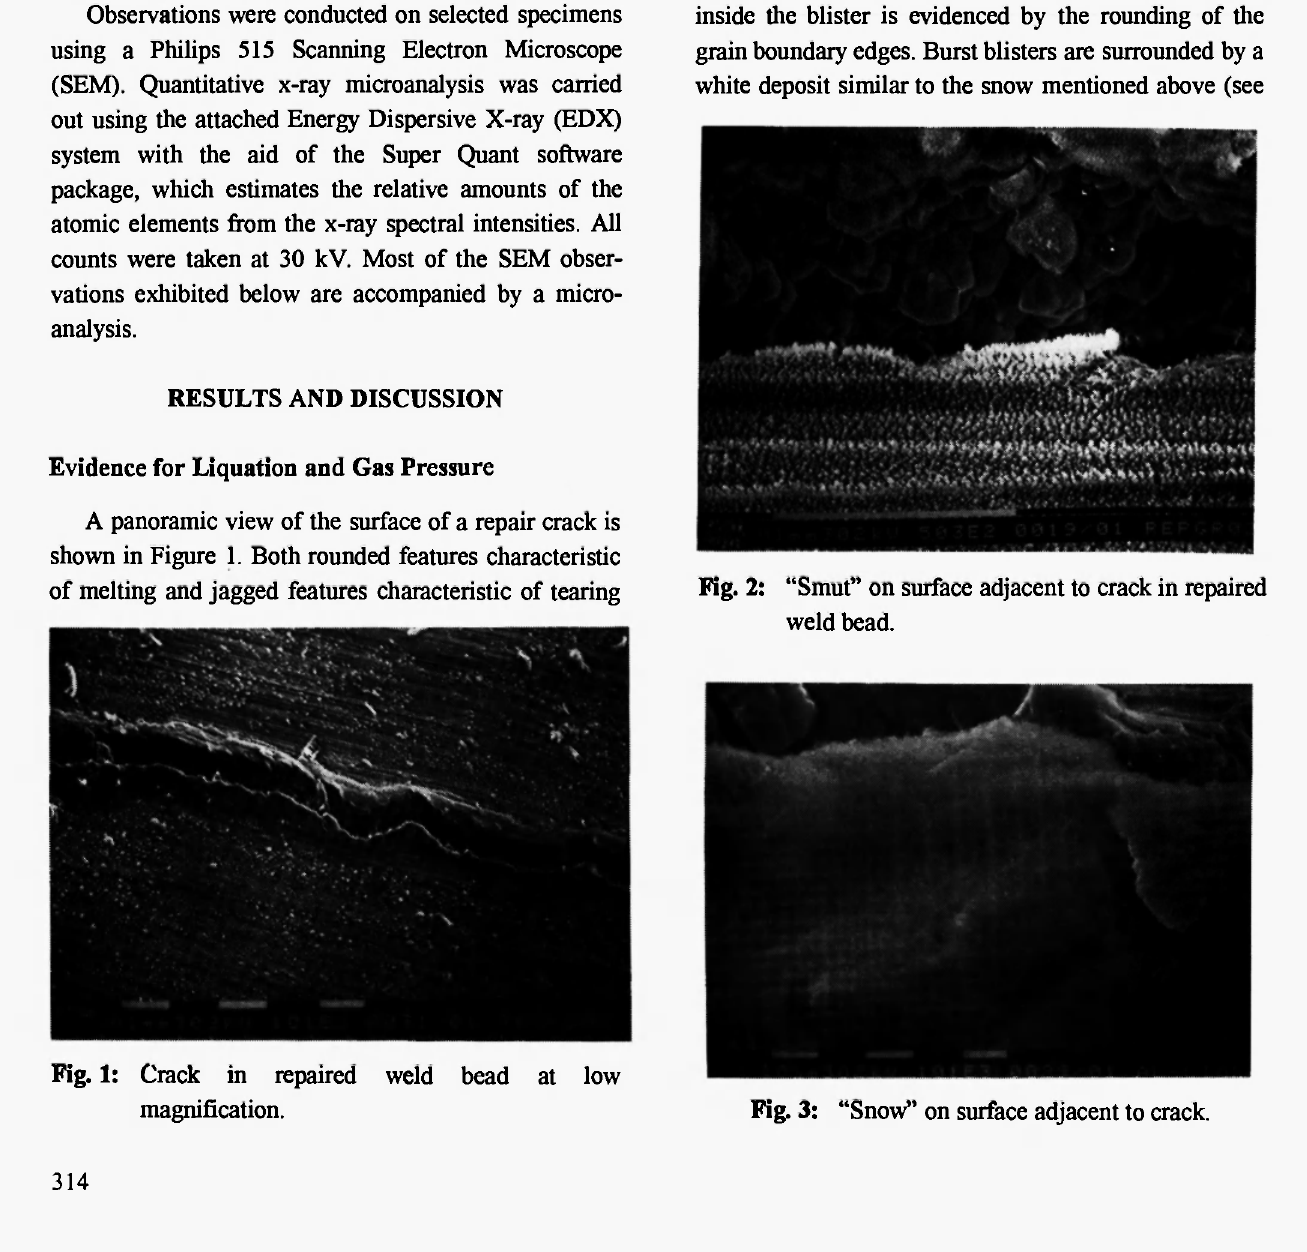
Fig. 3: "Snow" on surface adjacent to